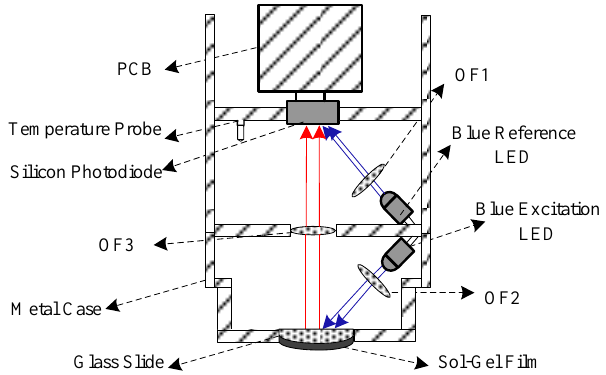
Figure 2. Schematic of the fluorescence quenching detection module.